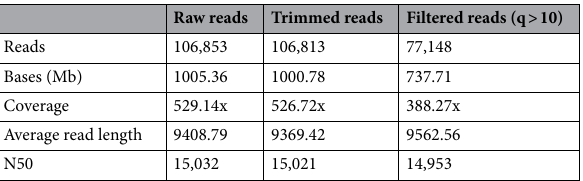
Table 1. Summary statistics for the assembly of S. thermophilus EG007 complete